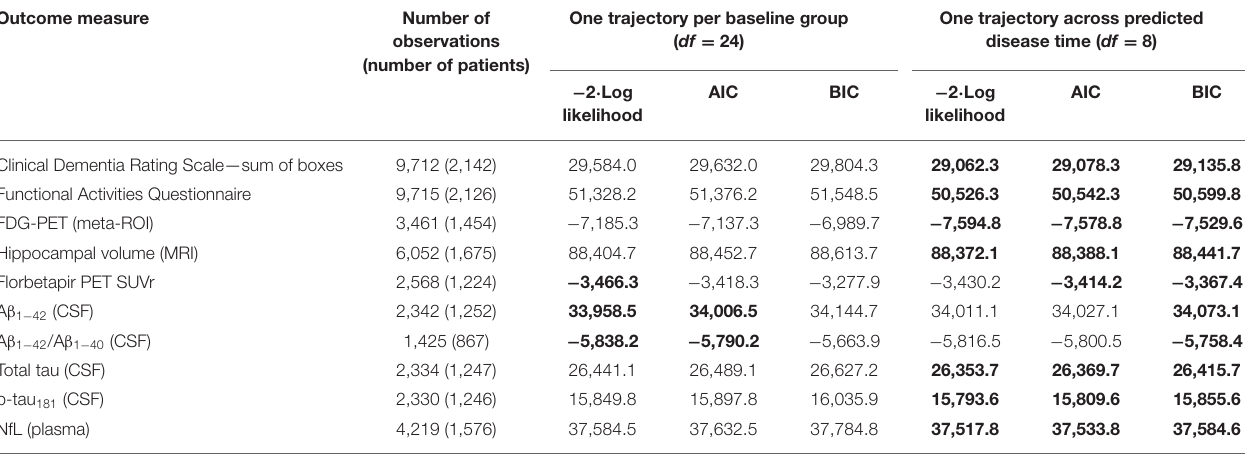
One trajectory per baseline group One trajectory across predicted observations ( df = 24) disease time ( df = 8) (number of patients) − 2 · Log BIC likelihood likelihood